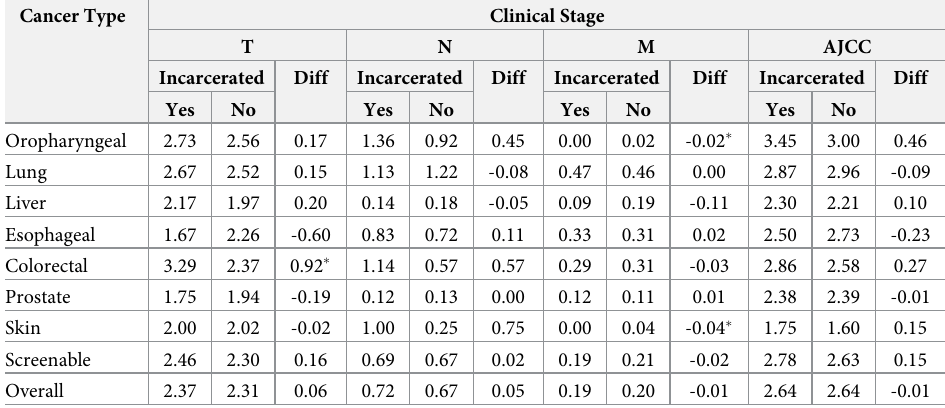
Table 2. Descriptive statistics of cancer staging by incarceration status.